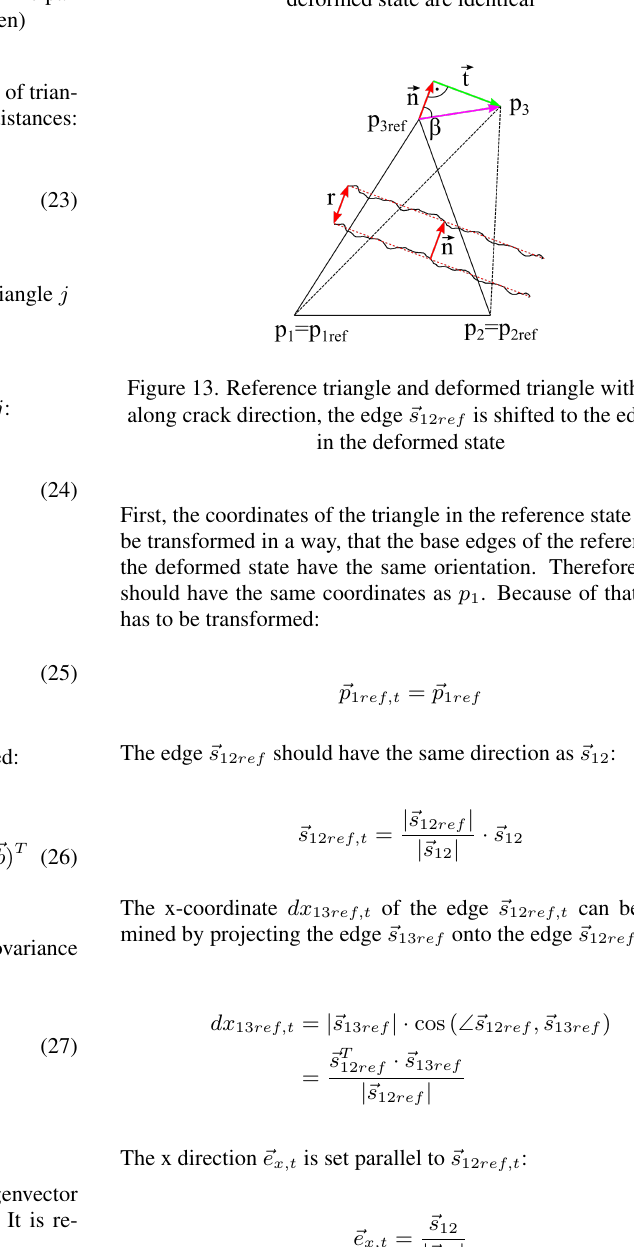
Figure 12. (a): crack through the reference triangle with a shift in crack direction; (b): new triangle in the deformed state; (c): both triangles, where the edges (cid:126)s 12 and (cid:126)s 12 ref in reference and deformed state are identical